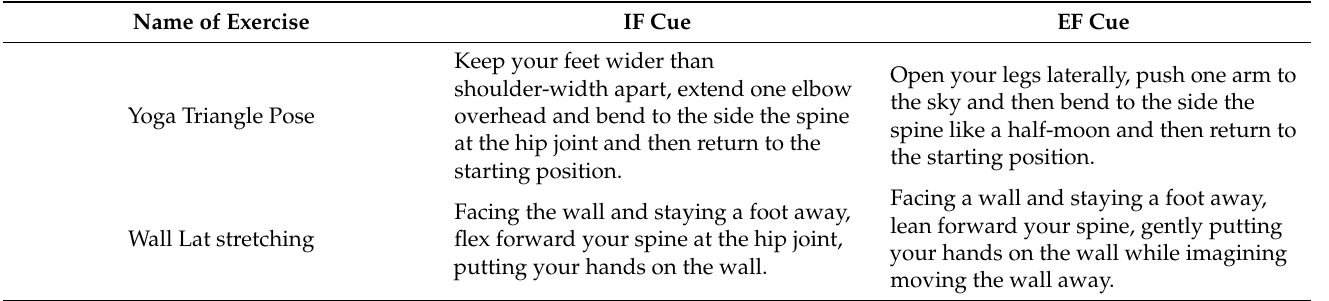
Table 1. Instructions performed by IF and EF